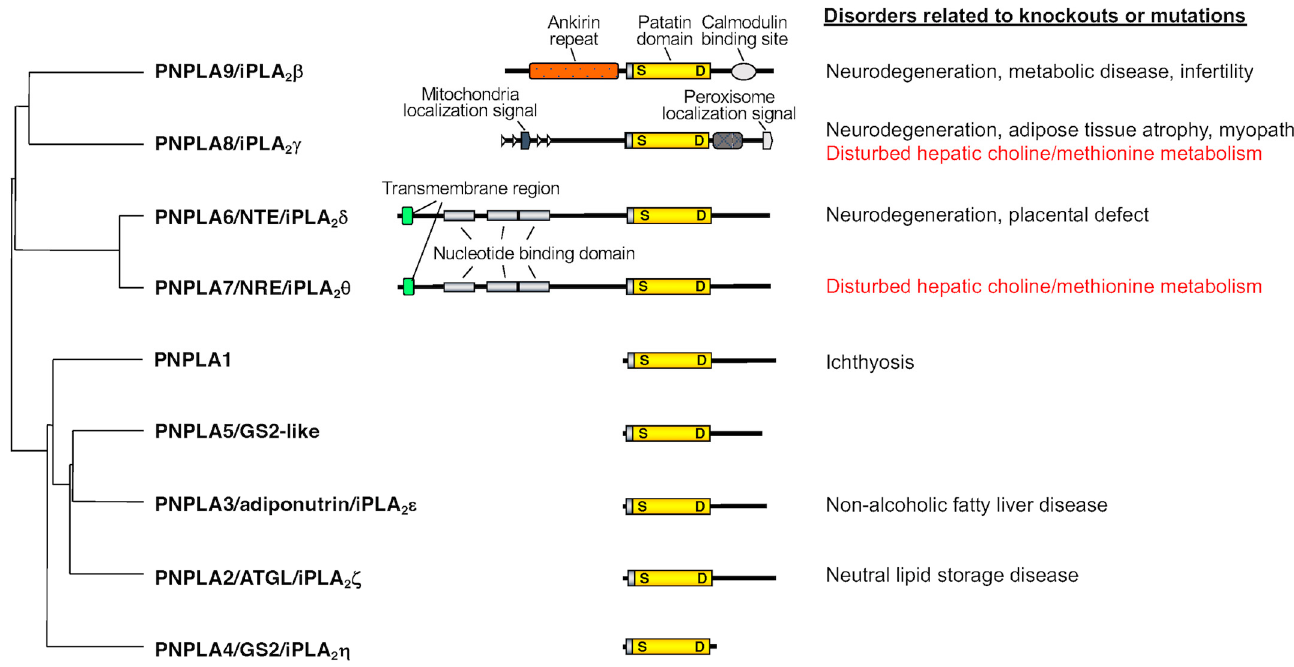
Figure 1. The PNPLA/iPLA 2 family. Structural relationship of PNPLA enzymes (PNPLA1~9), as well as representative disorders caused by knockouts or mutations of these enzymes in mice and humans, are indicated. In principle, PNPLA1~5 act on neutral lipids, while PNPLA6~9 act on phospholipids. The functional association of PNPLA7 and PNPLA8 with hepatic choline/methionine metabolism, on which we put a specific focus in this review, is highlighted in red.